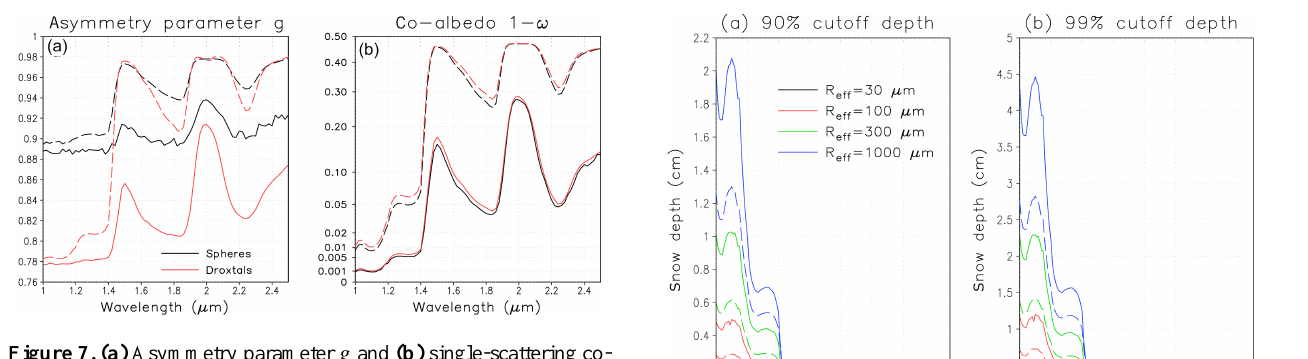
Figure 7. (a) Asymmetry parameter g and (b) single-scattering co- albedo 1- ω for spheres (black lines) and severely roughened drox- tals (red lines), for two values of volume-to-projected area equiv- alent radius: r VP = 50µm (solid lines) and r VP = 500µm (dashed lines).